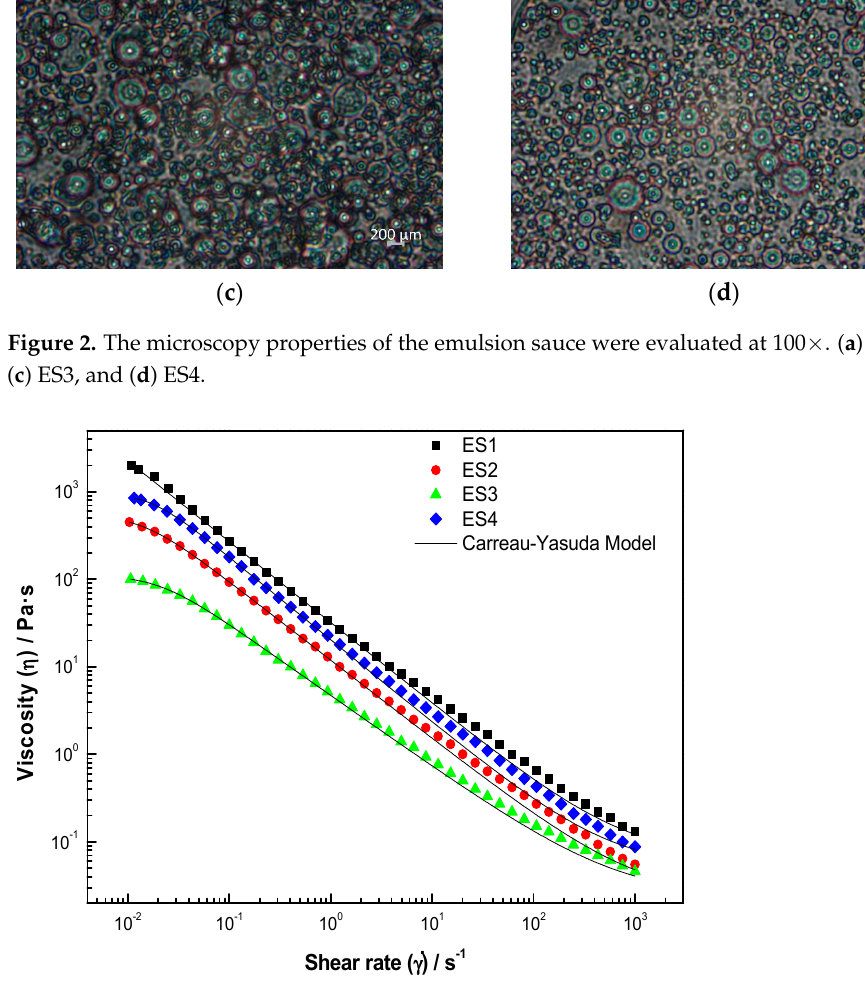
Figure 3. The viscous flow of dressing-type emulsions stabilized with hydrocolloids from butternut squash seeds at pH 10, adjusted to the Carreau–Yasuda